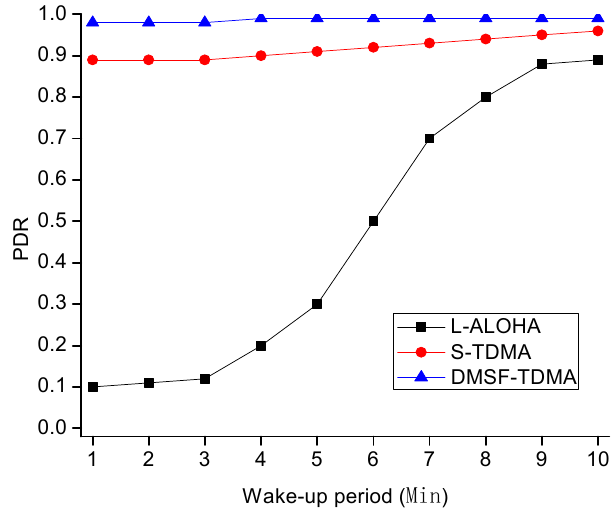
Figure 14. Average packet delivery ratio (PDR) with different wake-up periods.